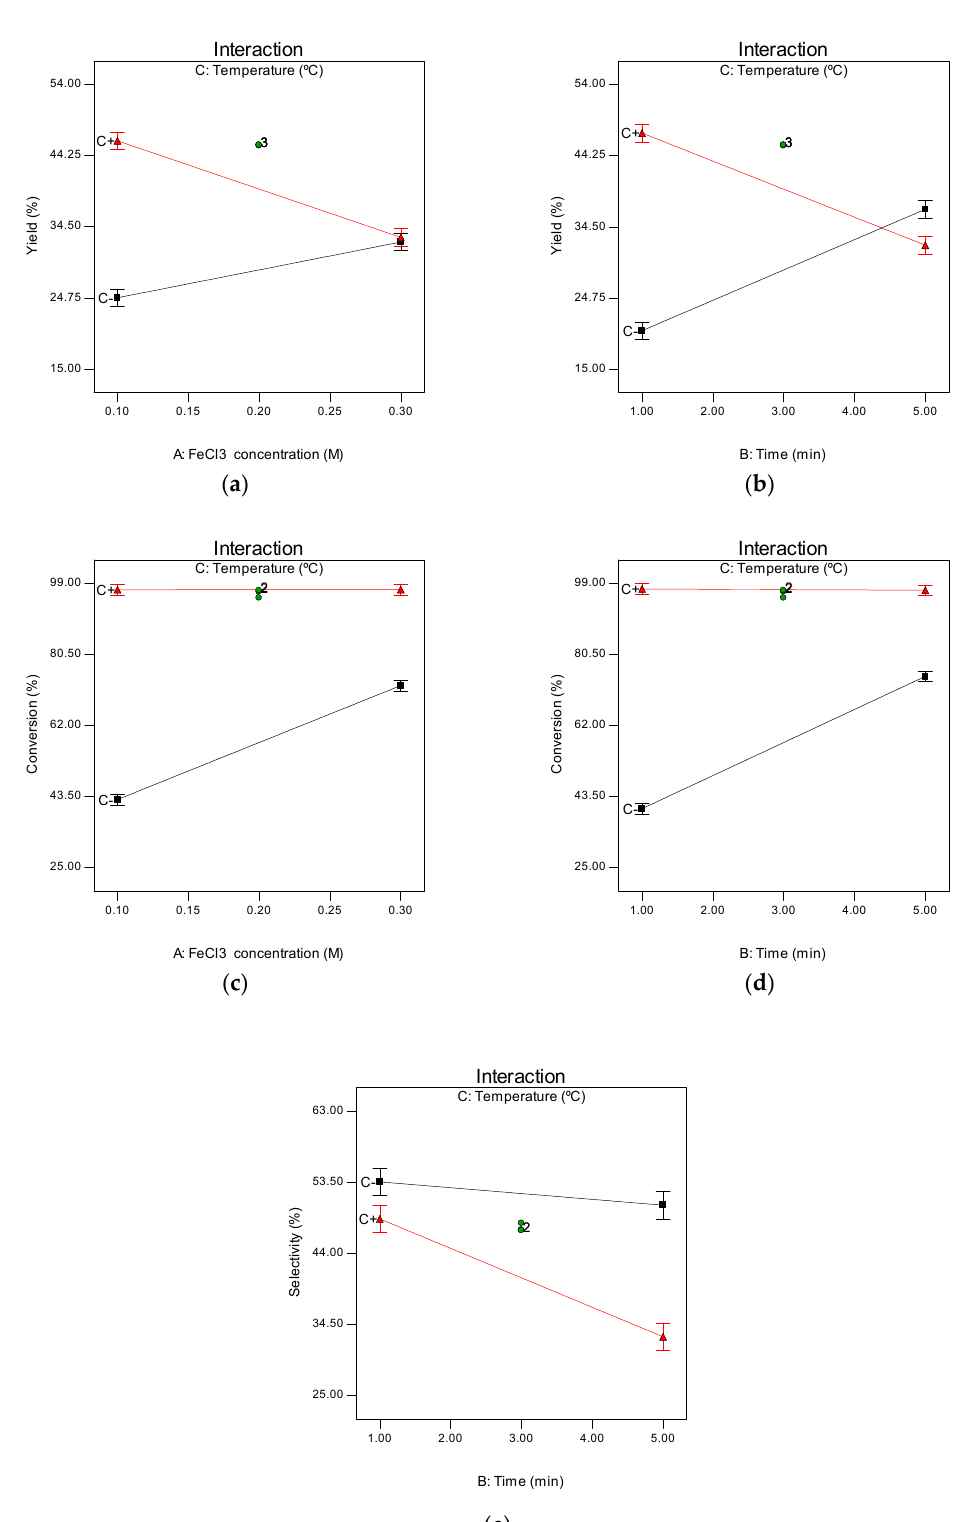
Figure 2. Interaction of factors studied in the factorial design: ( a ) interaction of FeCl 3 concentration and temperature in yield; ( b ) interaction of time and temperature in yield; ( c ) interaction of FeCl 3 concentration and temperature in conversion; ( d ) interaction of time and temperature in conversion; ( e ) interaction of time and temperature in selectivity. Red line, 200 °C; black line, 170 °C.